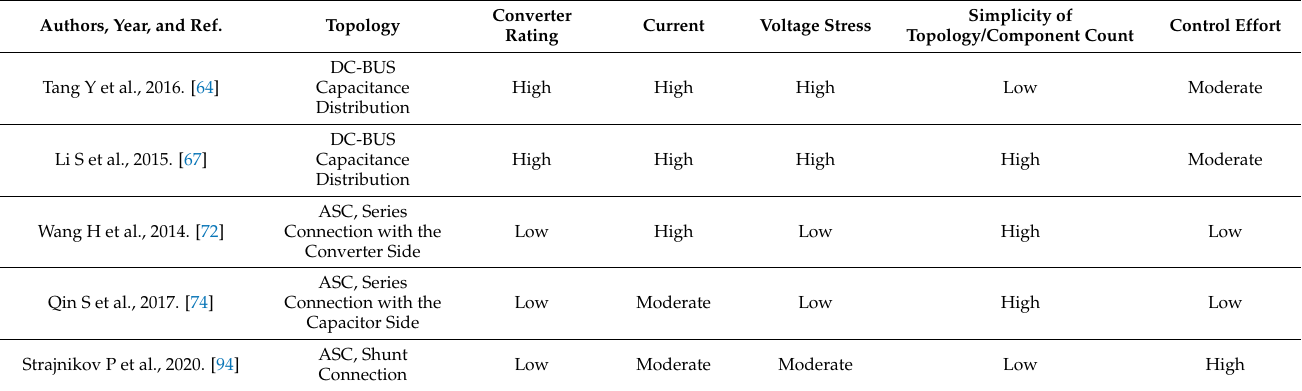
Table 2. Design considerations for ASC solutions according to the different